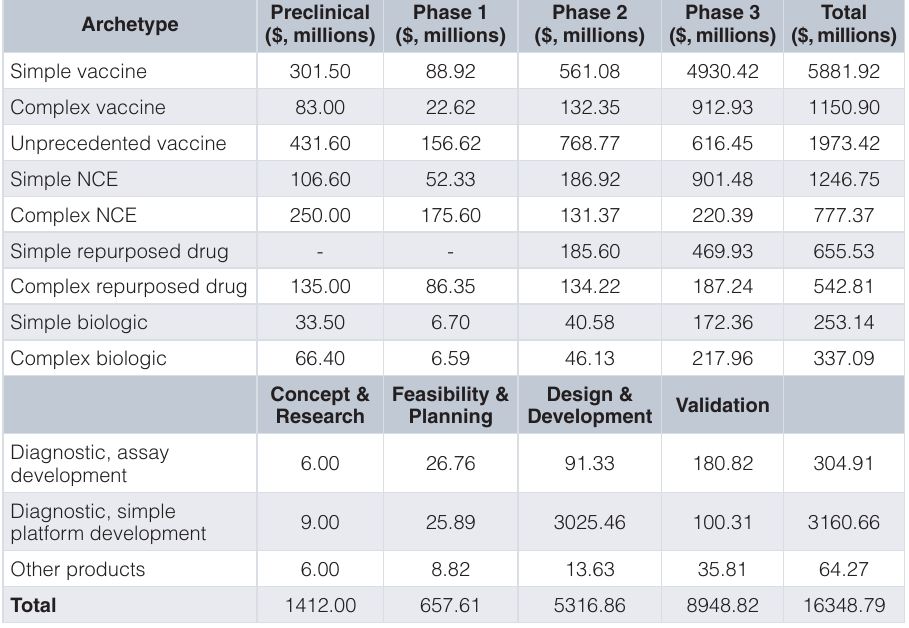
Table 7. Costs of moving current product candidates through the pipeline from their current phase.